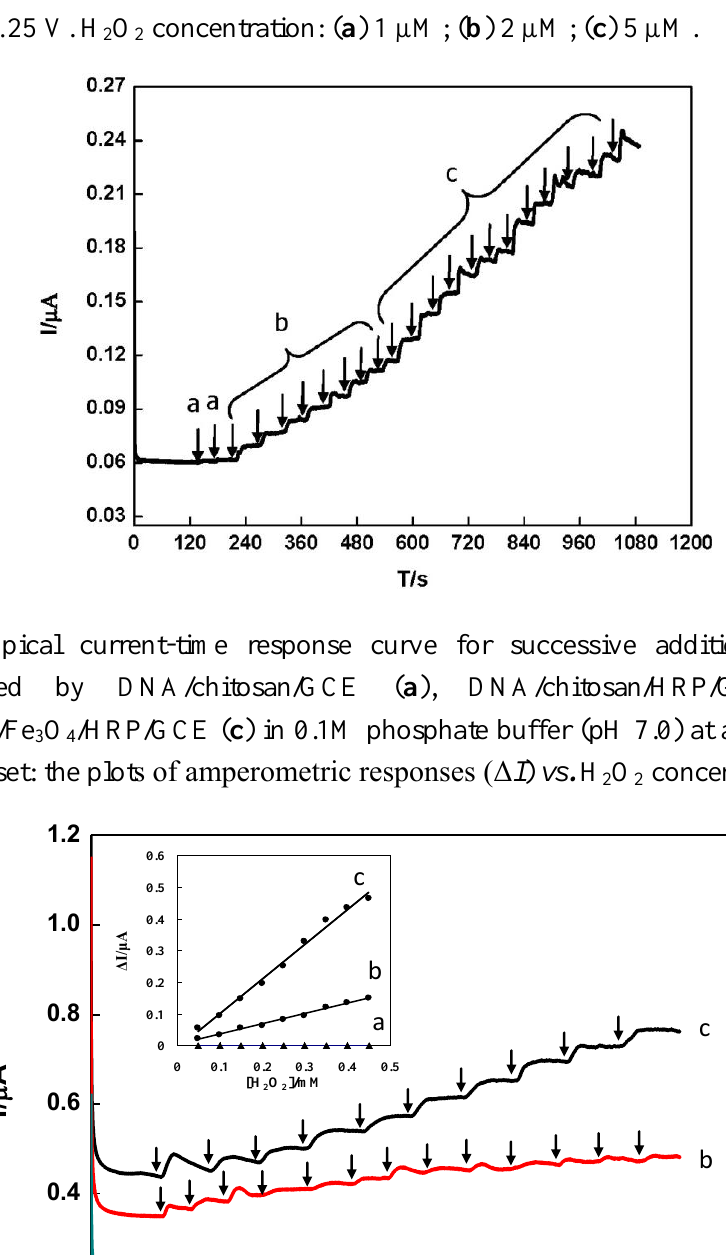
Figure 7. Typical current-time response curve of DNA/Fe successive addition of H